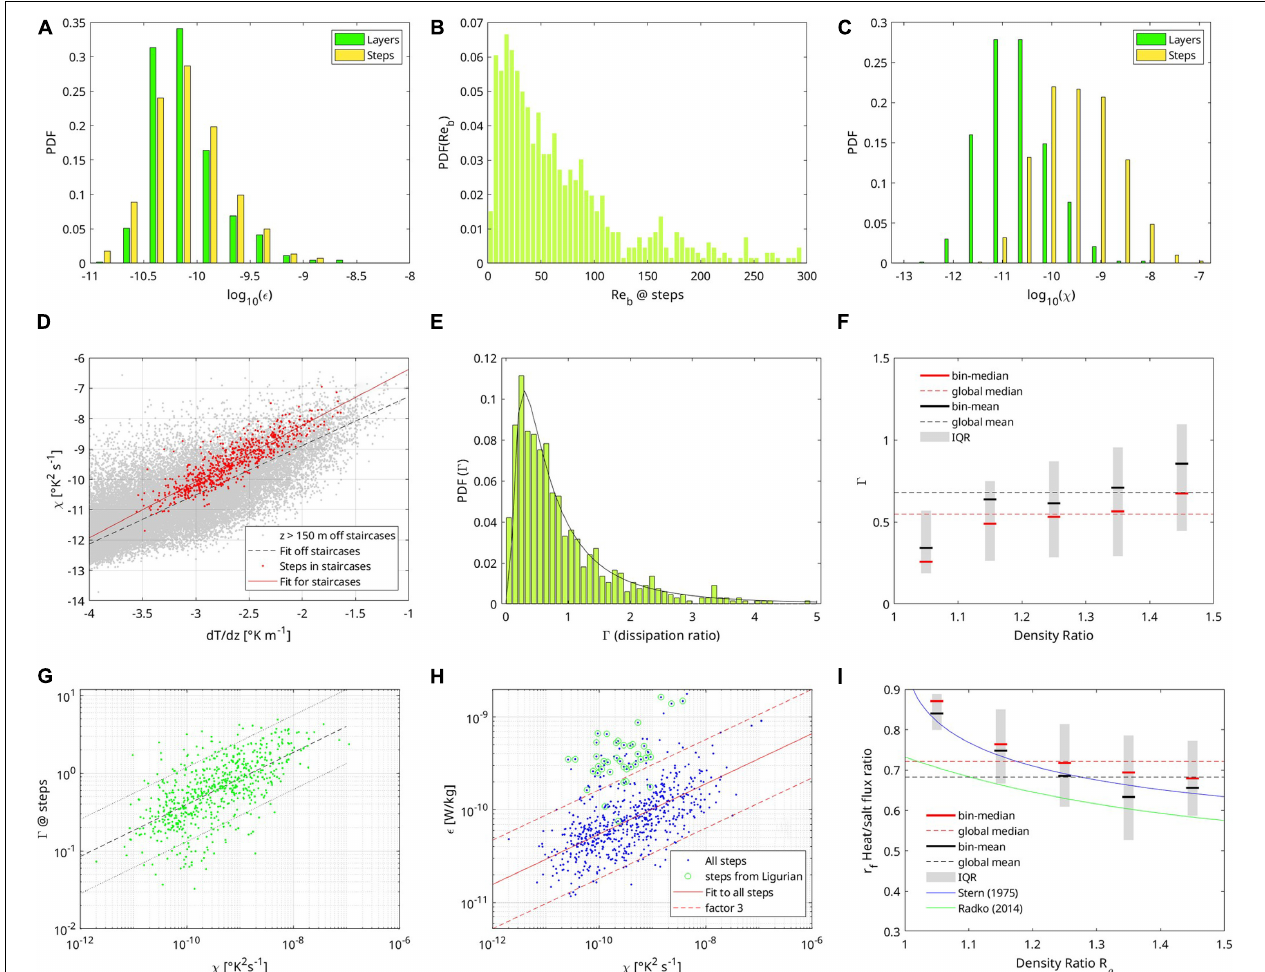
FIGURE 7 | (A) PDF of kinetic energy dissipation rates ε (units W kg − 1 ) for steps (yellow) and layers (green), (B) PDF of turbulence intensity Re b for steps, (C) PDF of temperature variance dissipation rates χ ( ◦ K 2 s − 1 ) for steps (yellow) and layers (green), (D) distribution of χ as a function of the vertical temperature gradient θ z for regions without any staircase deeper than 150 m (gray dots with dashed black linear fit) and for the steps of staircases (red dots with dark red linear fit), (E) PDF of observed dissipation ratio (cid:48) (bars) for steps with its lognormal fit (black line), (F) (cid:48) per density ratio (R ρ ) bin with the median (red line) and mean (black line) for each bin and the global median (red dashed) and mean (black dashed) for bins having at least 30 steps, the interquartile range (IQR, 50% of the data, gray bars) shows the scatter of the data per bin, (G) (cid:48) vs. χ for steps (green dots) with a fit in the loglog phase space (black dashed) and a factor of 3 range from the fit (dotted lines), (H) ε vs. χ for steps (all steps: blue dots; Ligurian: green circles) with a fit in the loglog phase space (red solid line) and a factor of 3 range (red dotted lines), (I) same as (F) for the heat to salt buoyancy-flux ratio r f vs. R ρ , with the Stern (1975) relationship (blue